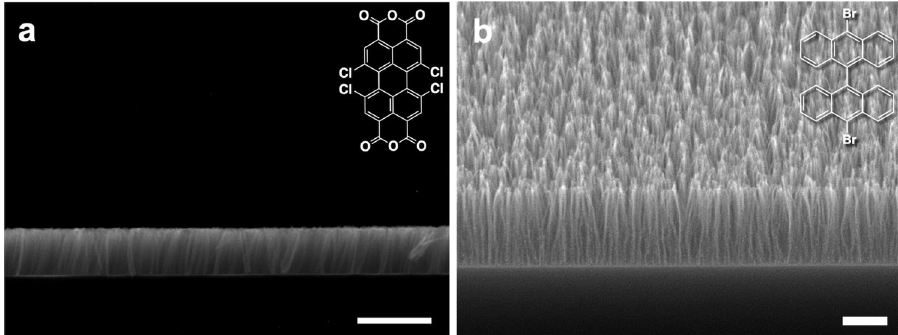
Fig. 4 Side view of standing nanowires. a Side view SEM image of free-standing nanowires fabricated via irradiation of 300 nm PTCDA-Cl 4 fi lm with 120 MeV 197 Au 9 + at 1 × 10 11 cm − 2 and subsequent sublimation. b SEM image of free-standing nanowires fabricated via irradiation of 1300 nm DBBA fi lm